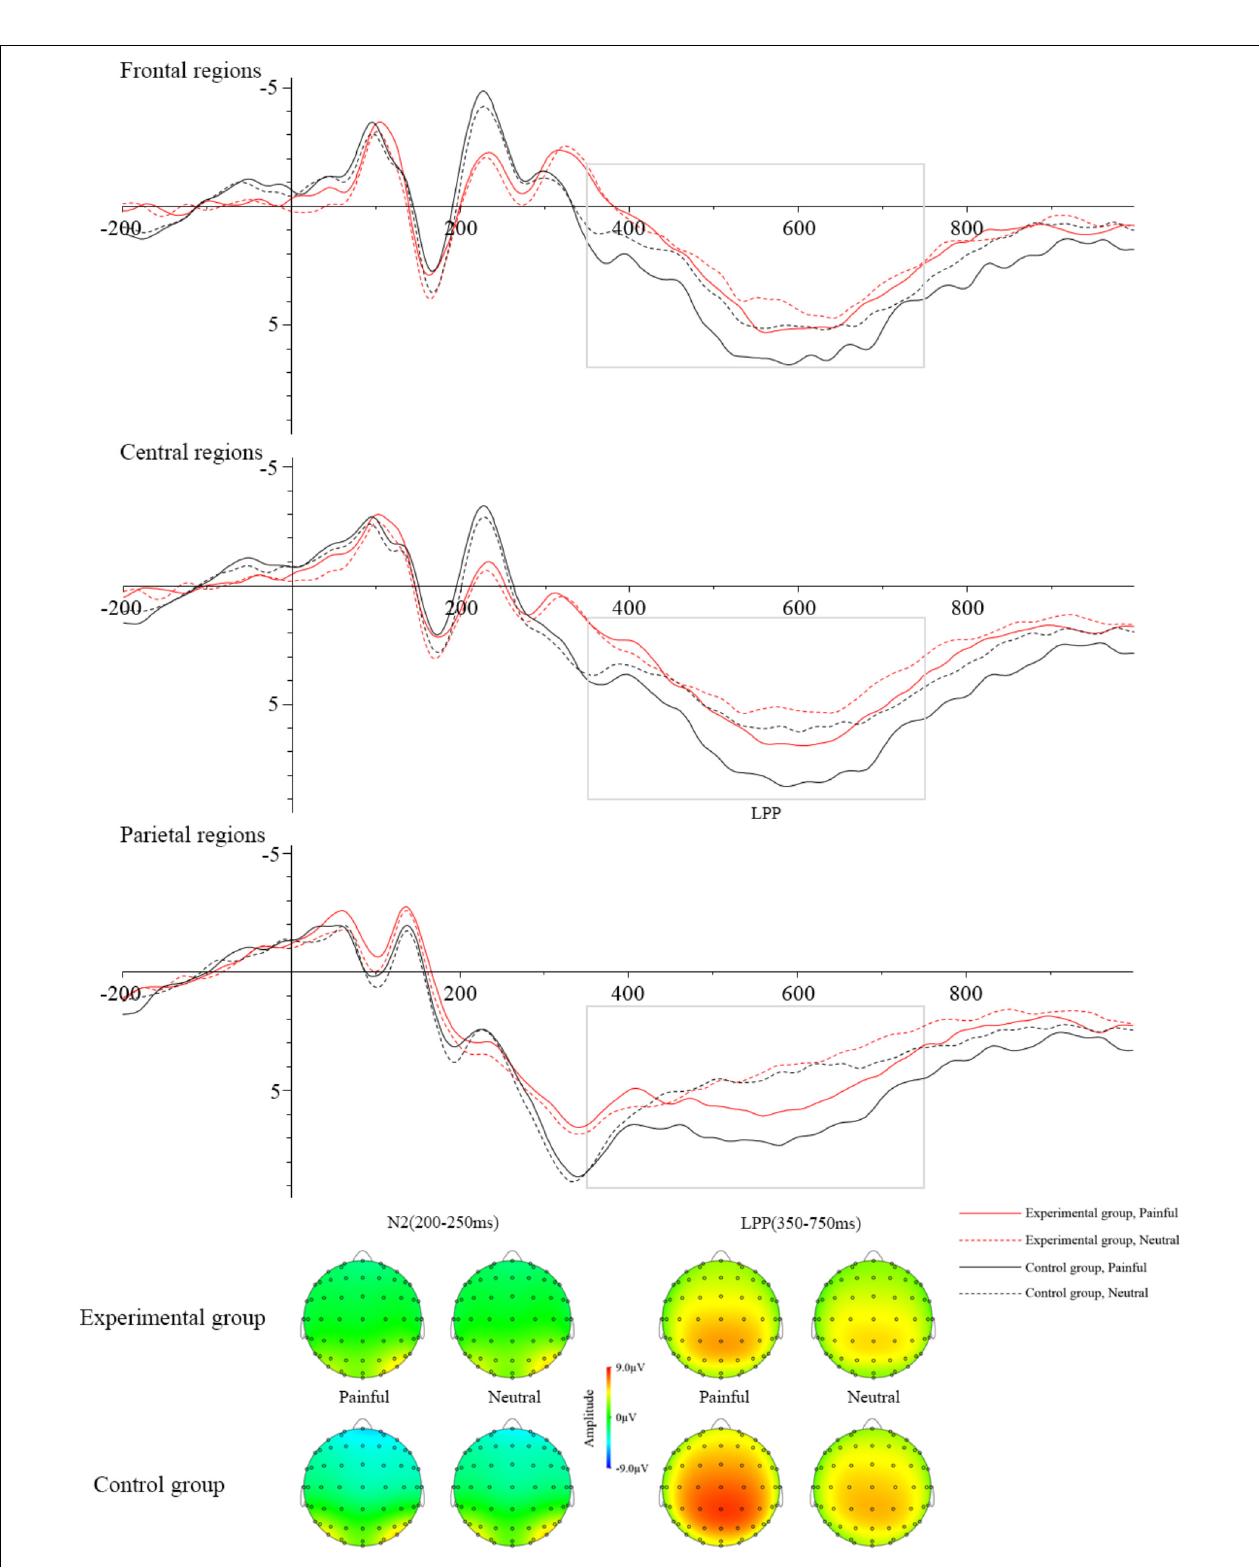
FIGURE 2 | Grand averages of ERPs at Frontal regions, Central regions, and Parietal regions when watching painful pictures in the control group (black solid line), painful pictures in the experimental group (red solid line), neutral pictures in the control group (black dotted line), and neutral pictures in the experimental group (red dotted line). The voltage topographies illustrate the scalp distribution of N2 and LPP